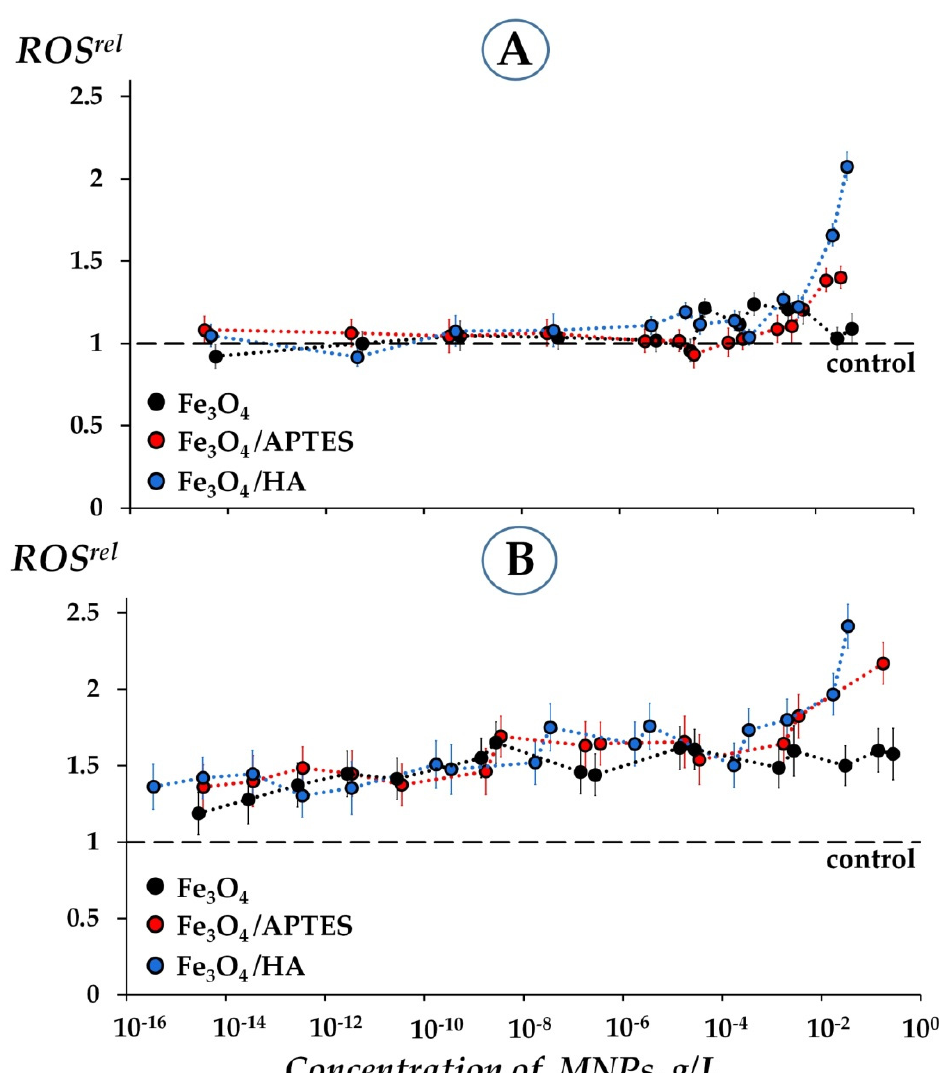
Figure 4. Relative ROS content, ROS rel , at various concentrations of MNPs in suspensions of two types: ( A ) bacteria-free solutions, ( B ) bacterial suspensions. Contents of ROS in the control samples were ~3 × 10 − 6 M in both bacteria-free ( A ) and bacterial ( B ) media. Bare Fe 3 O 4 –black circles, Fe 3 O 4 /APTES–red circles, and Fe 3 O 4 /HA–blue circles.